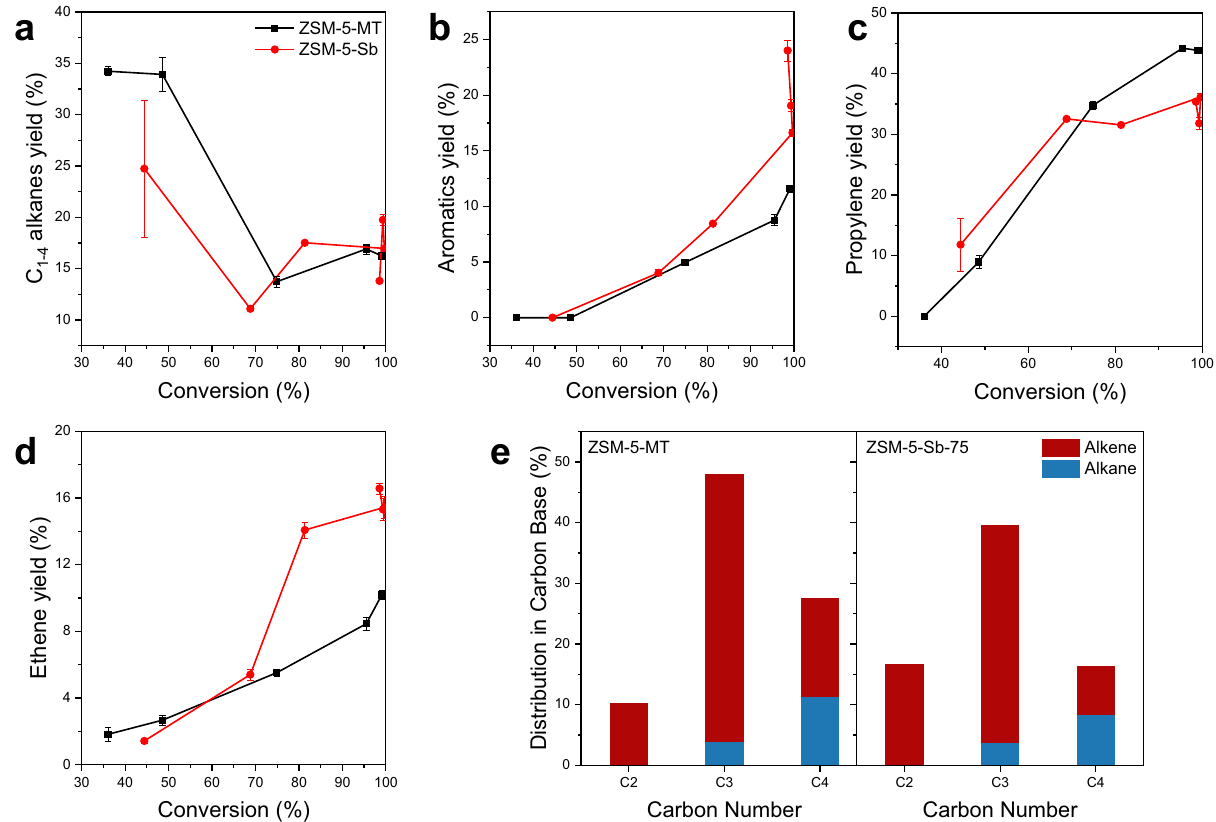
Fig. 4 Catalytic performance of ZSM-5-MT catalyst. Yields of light alkanes ( a ), aromatics ( b ), propylene ( c ), and ethene ( d ) as a function of the conversion of methanol with ZSM-5-MT and ZSM-5-Sb-75 catalysts. e Distribution of different carbon numbers of hydrocarbon products for ZSM-5-MT and ZSM-5-Sb-75 catalysts at complete methanol conversion ( ≥ 99%) (Test conditions: 475 °C, weight hourly space velocity (WHSV) of 3 h − 1 ). The error bars in a to d represent the standard deviations of three sets of data in repeated